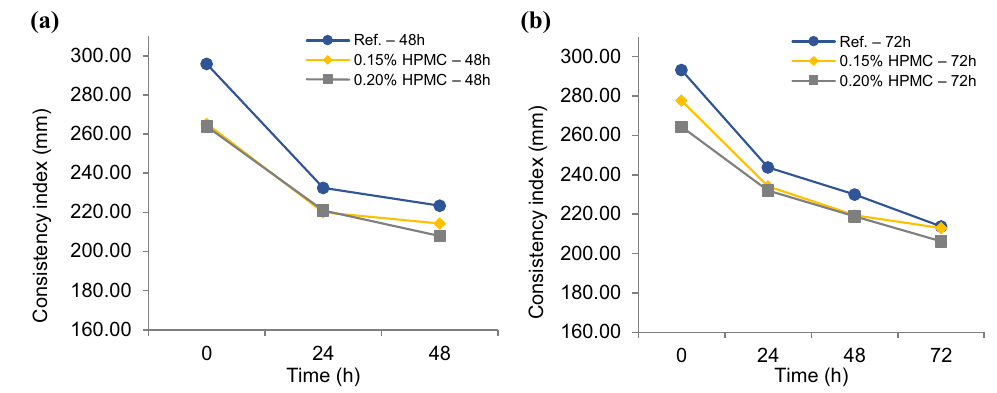
Figure 8: Consistency index over time of stabilized mortars. ( a ) 48 h; ( b ) 72 h.